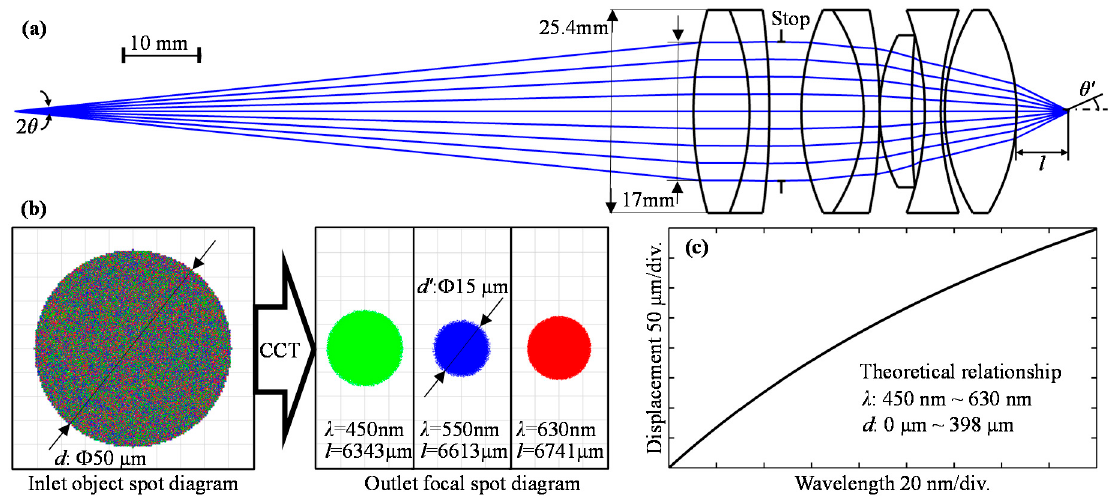
Figure 1. Schematic diagram of the chromatic confocal technology (CCT) system.